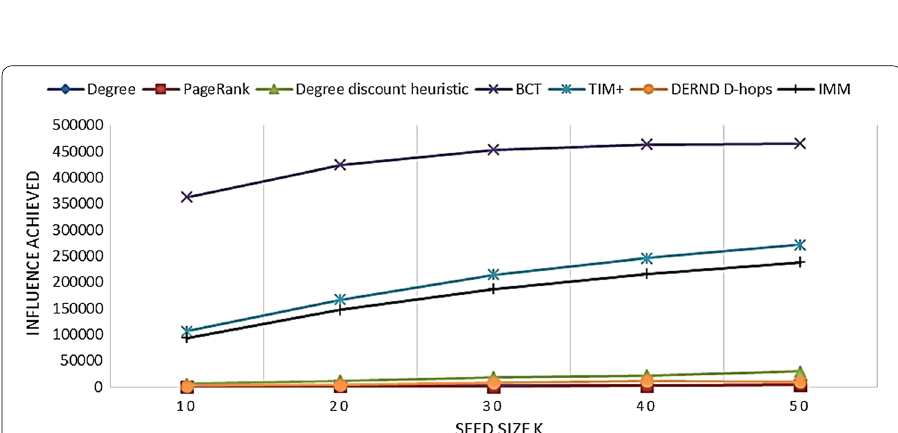
Fig. 6 Influence coverage under for LT model on Twitter data. Degree PageRank Degree discount heuristic BCT TIM UERND D-hops +